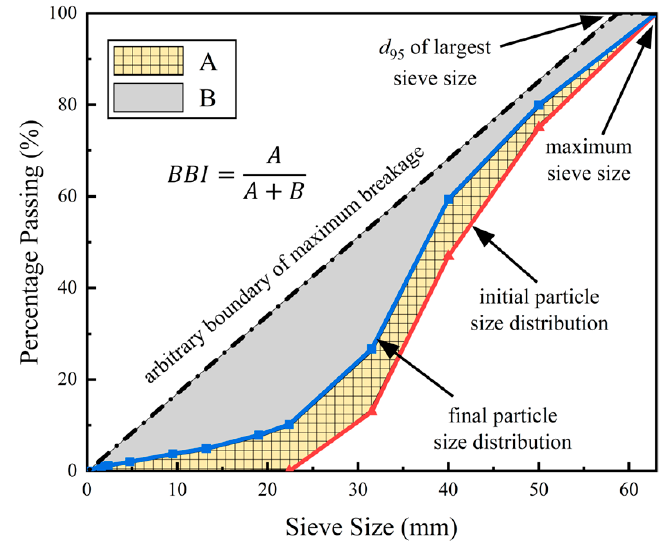
Figure 7. Illustration of the definition of ballast breakage index (BBI).